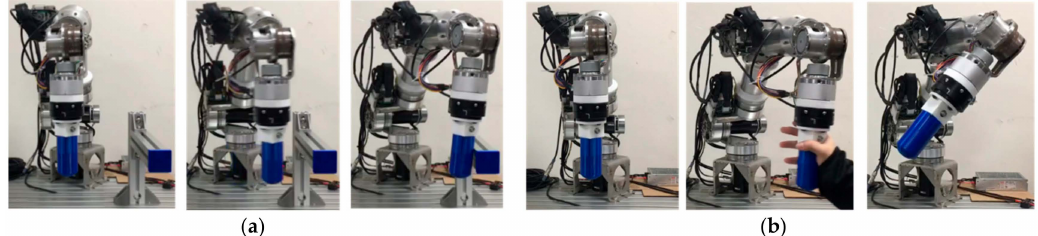
Figure 12. Safety control experiment: ( a ) Collision detection; ( b ) External force detection.